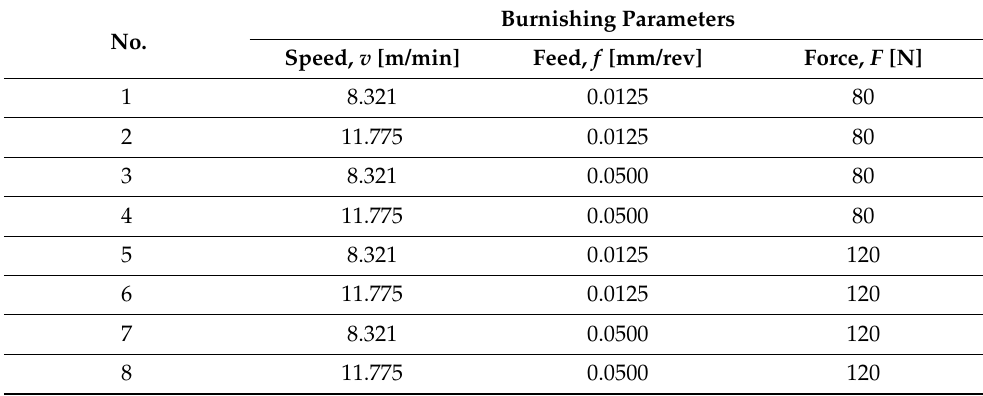
Table 2. The parameters of burnishing in SI